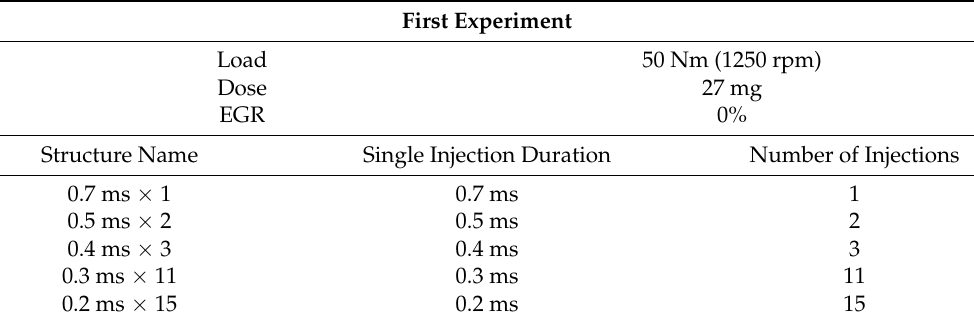
Table 2. Cases of the first experiment.